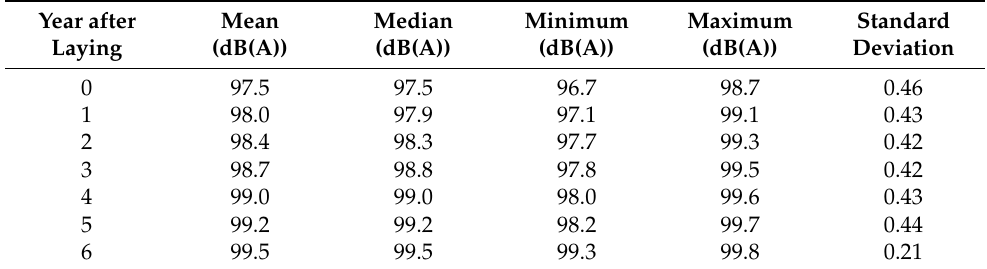
Table 1. Basic statistical analysis of noise values for the exposed aggregate cement concrete surface with the highest grain size of 8 mm (EACC